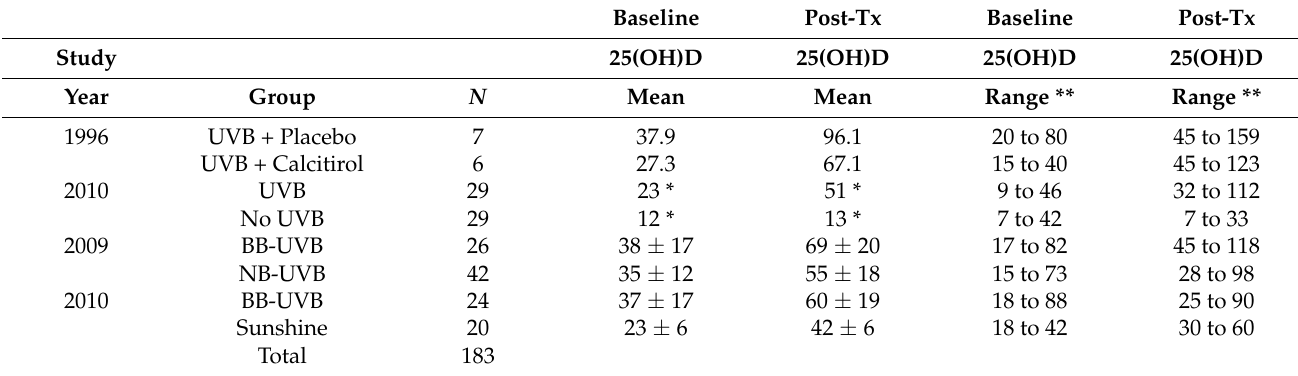
Table 4. Study year, type of phototherapy of used, number of patients treated, baseline and post treatment mean serum 25(OH)D concentrations, and baseline and posttreatment range at of serum 25(OH)D concentrations in the phototherapy clinical trials reviewed.